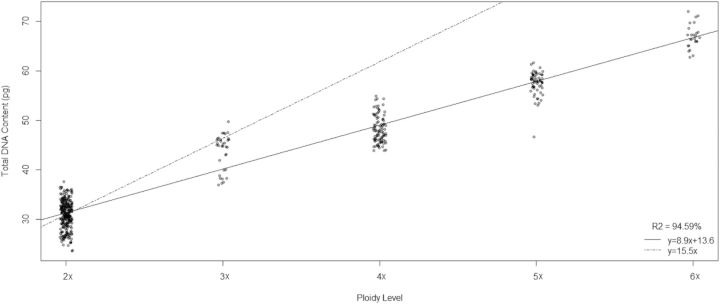
Total DNA content (2C) plotted against ploidy level. Solid line, linear fit; broken line, extrapolated from diploids.